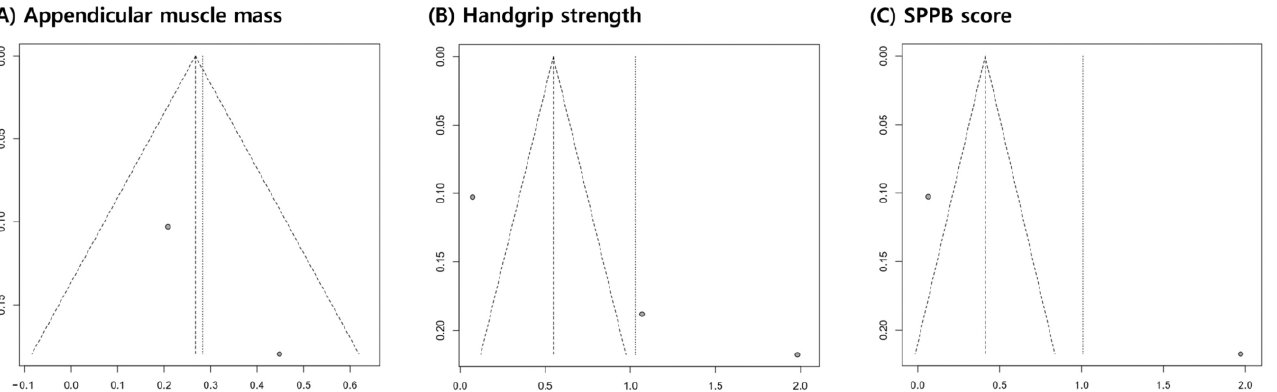
Figure 5. Graphic funnel plot of the included studies. The x-axis represents the standardized mean difference, and the y-axis represents the standard error.